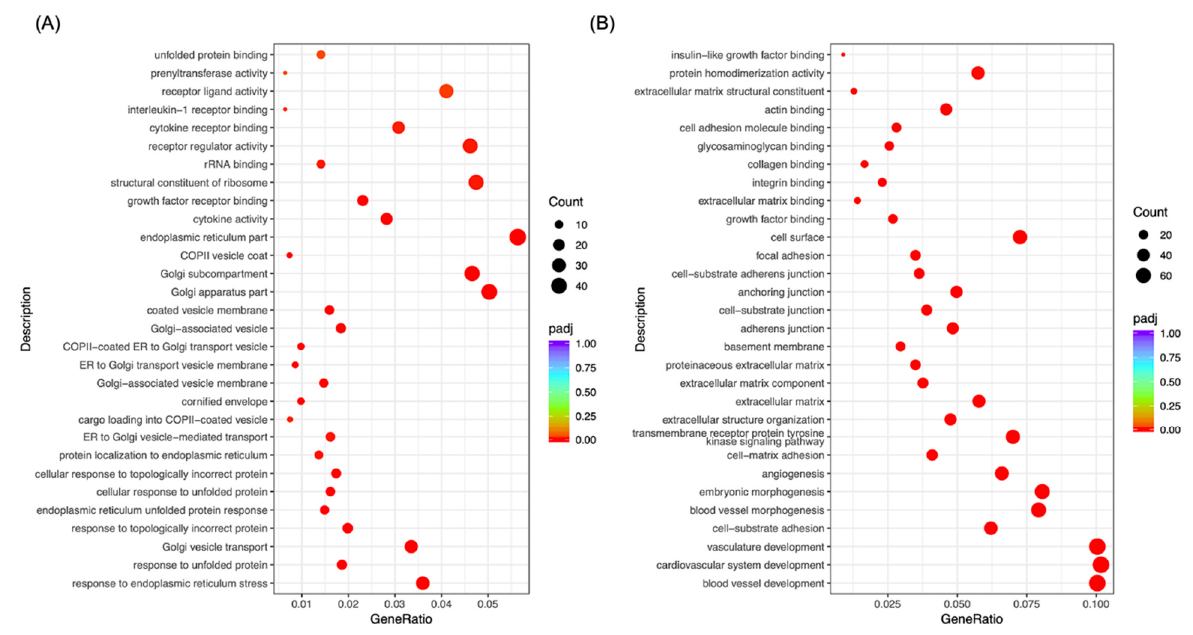
Figure 3. Functional annotation of the differentially expressed genes (DEGs, p adj < 0.05 and fold change > 2) in ruminal epithelial cells (RECs) based on Gene Ontology (GO) enrichment analysis. ( A ) GO terms of the overlapping DEGs that were downregulated in the Morusin+LPS group compared with LPS group and upregulated in the LPS group compared with NC group. ( B ) GO terms of the overlapping DEGs that were upregulated in the Morusin+LPS group compared with LPS group and downregulated in the LPS group compared with NC group. Only the top 30 GO terms with a p -value < 0.05 were presented. Circles indicate the numbers of enriched genes, colors indicate the p adj values. RECs were treated without (NC, n = 4) or with 0.1 µg/mL lipopolysaccharide for 3 h after pretreating with 50 µg/mL of Morusin for 12 h (Morusin+LPS, n = 4) or not (LPS, n = 4).